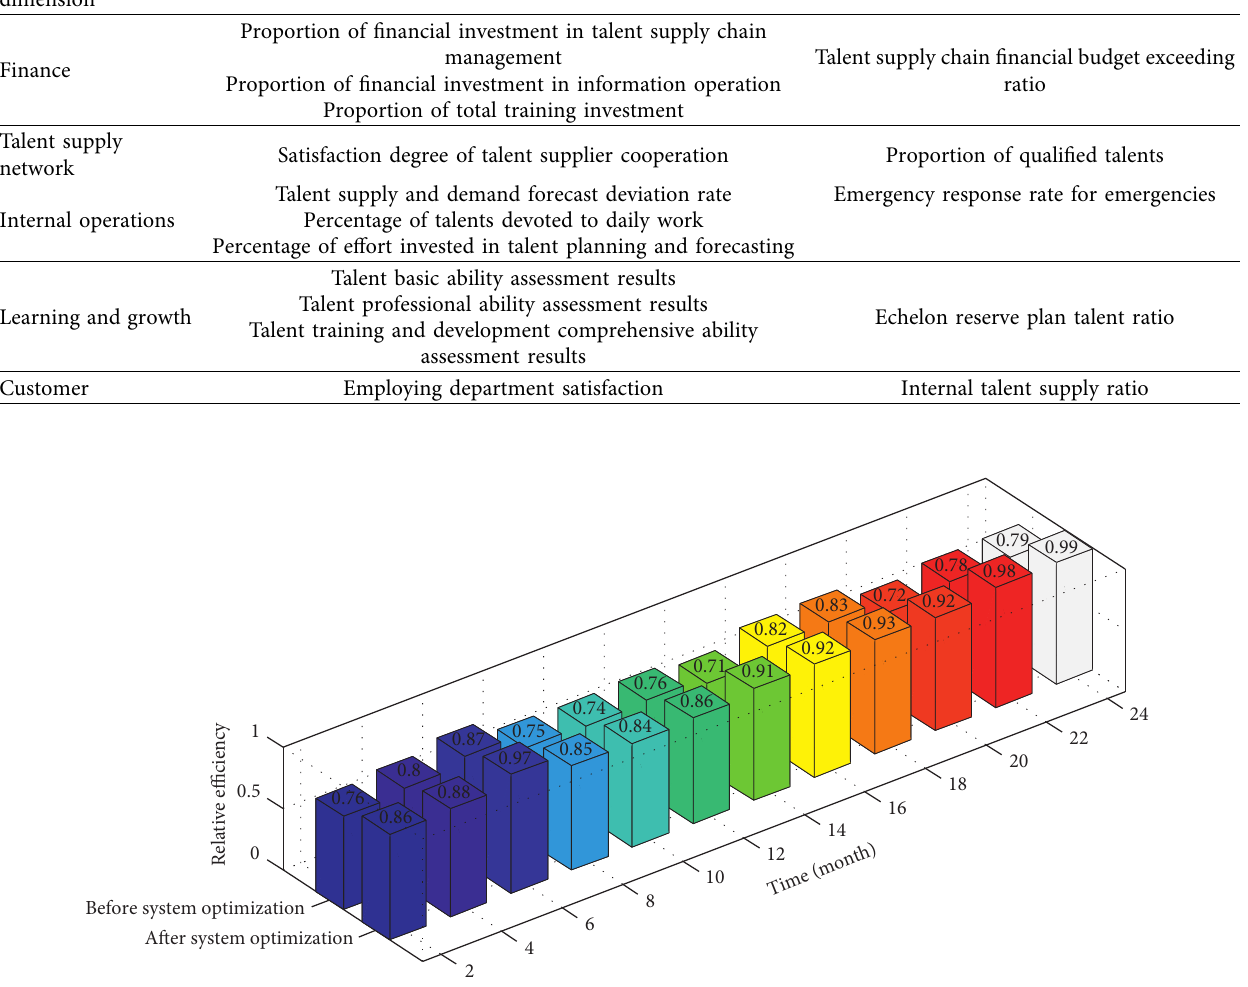
Figure 7: Relative efficiency before and after system